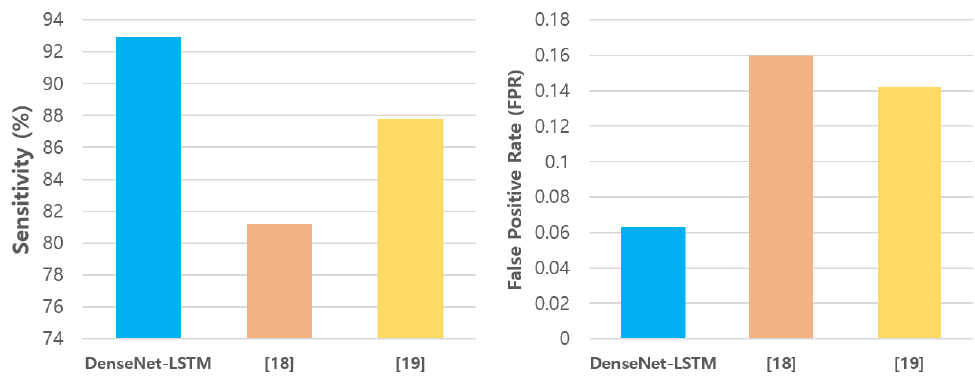
Figure 10. Comparison of the proposed method with previous studies